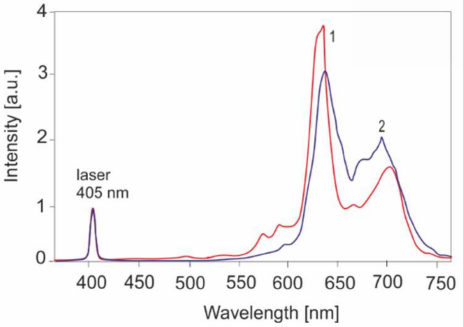
Figure 8. Fluorescence of metalloporphyrins: enamel plaque (1) and skin in senilis keratosis